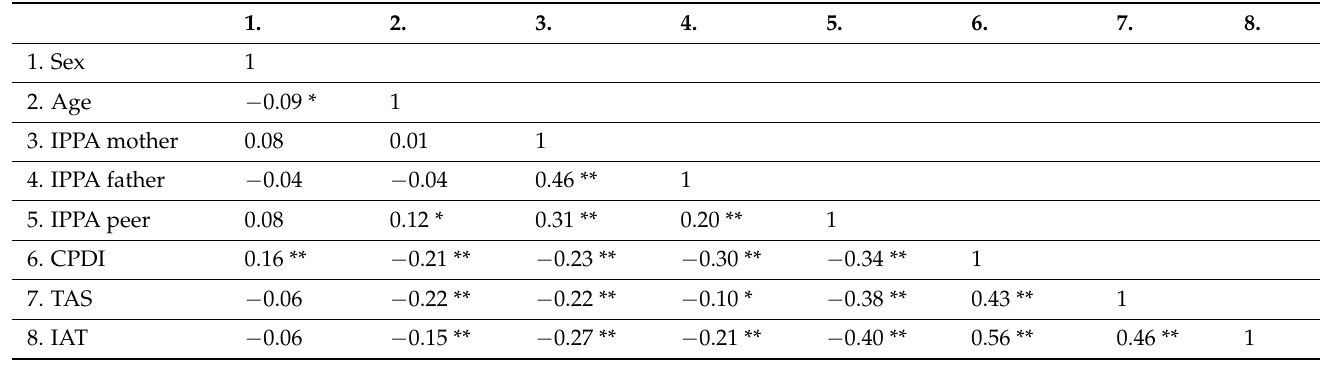
Table 4. Pearson correlation coefficients between the starting theoretical model